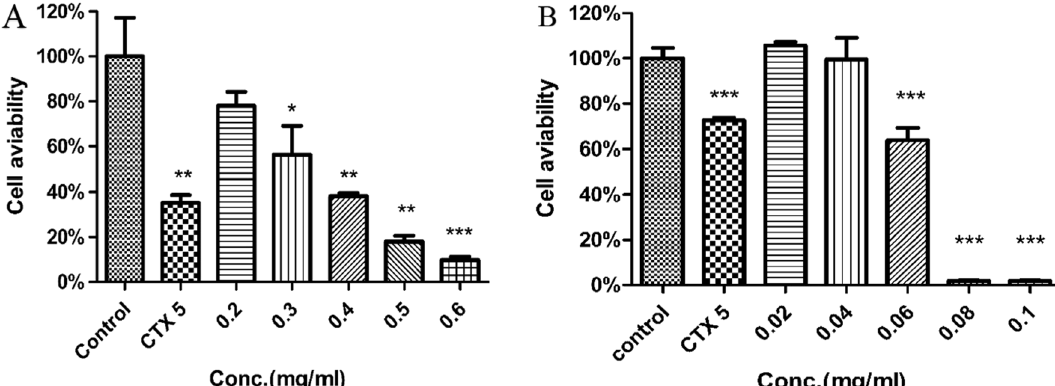
Figure 8. Ginseng leaves extract and F2 significantly decreases the viability of human lung adenocarcinoma cells. (A) Effects of the ginseng leaves extract on the viability of A549 cells. (B) Effects of the F2 on the viability of A549 cells.